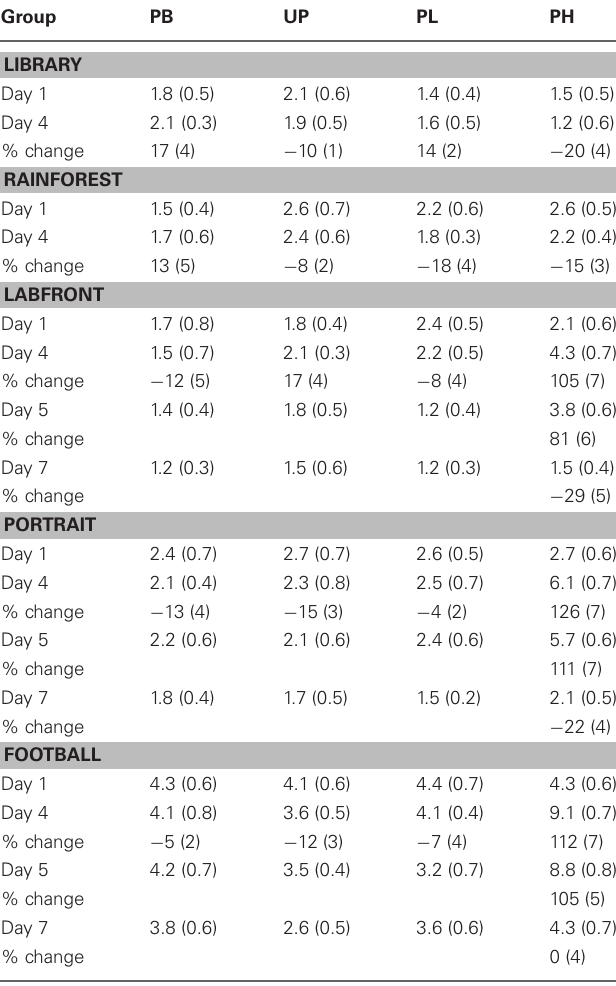
Table 3 | Means (SDs) of positive affect ratings for association and extinction